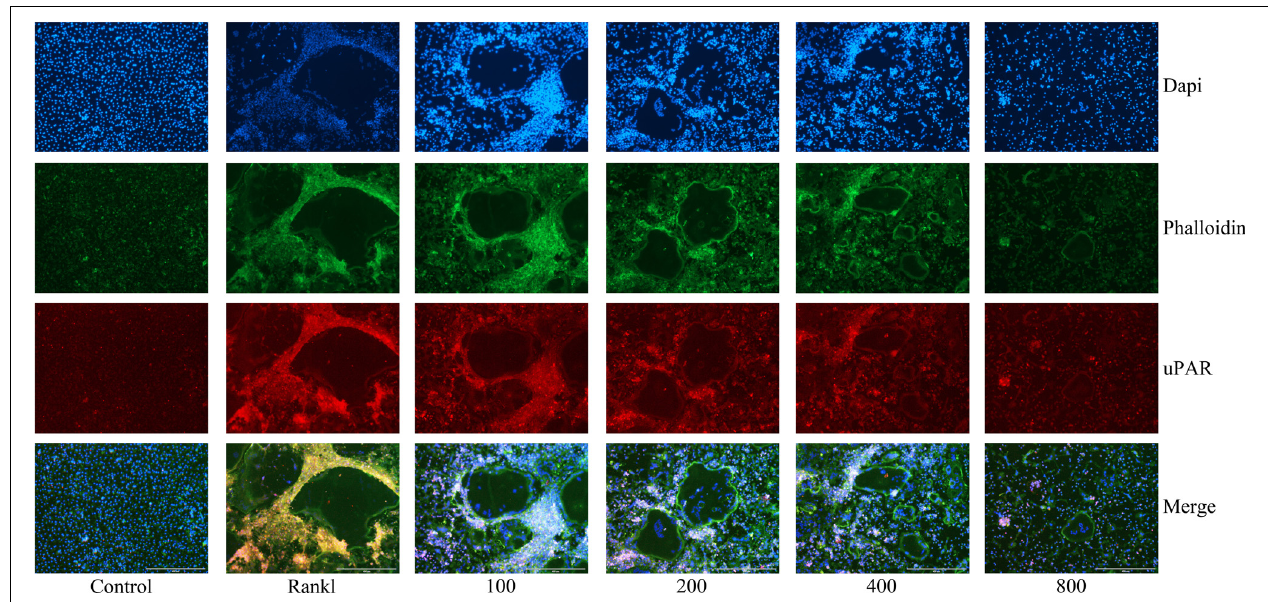
FIGURE 6 | Ulinastatin decreased actin ring formations and suppressed uPAR expression. C represents control group, R represents RANKL group, 100 ∼ 800 represents RANKL + 100 units/mL ulinastatin ∼ RANKL + 800 units/mL ulinastatin group. BMMs (1 × 10 4 cells/well) were cultured with M-CSF (30 ng/mL) and RANKL (100 ng/mL), treated with four different concentrations of ulinastatin (100, 200, 400 and 800 units/mL) for 4 days. Then the cells were stained for actin ring assay and Immunofluorescence assay. Images were obtained by fluorescence microscopy. The experiment was performed three times